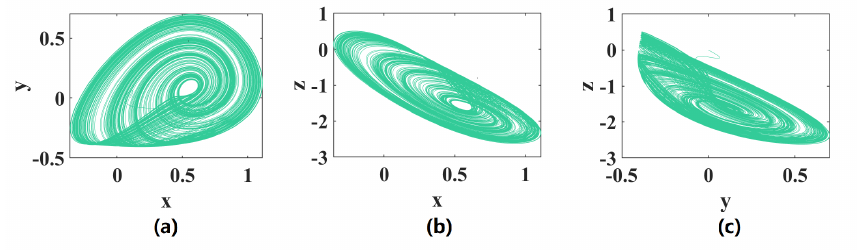
Figure 2. Phase portraits with q = 0.98, k = 1.32. ( a ) x-y plane ; ( b ) x-z plane; ( c ) y-z plane.